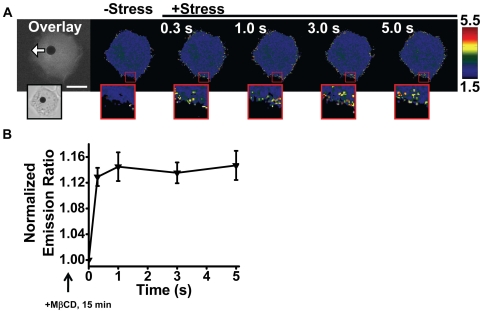
Rapid Rac activation despite extraction of cholesterol from the plasma membrane.(A) Representative time-lapse emission ratio images of a SYF−/− MEF cell treated with 10 mM of methyl-β-cyclodextrin (MβCD) for 15 min to selectively extract cholesterol from the plasma membrane before the application of stress. Inset shows the enlarged area of the cell periphery where rapid activation of Rac is observed. The left inset panel shows the brightfield image of the cell with a magnetic bead (black dot) bound to the apical surface. (B) Normalized emission ratio time course of SYF −/− MEFs in response to 17.5 Pa stress pretreated with methyl-β-cyclodextrin (MβCD). This shows that the activation of Rac occurs independent of the integrity of lipid rafts at the plasma membrane. (n = 4 cells, mean +/− s.e.).